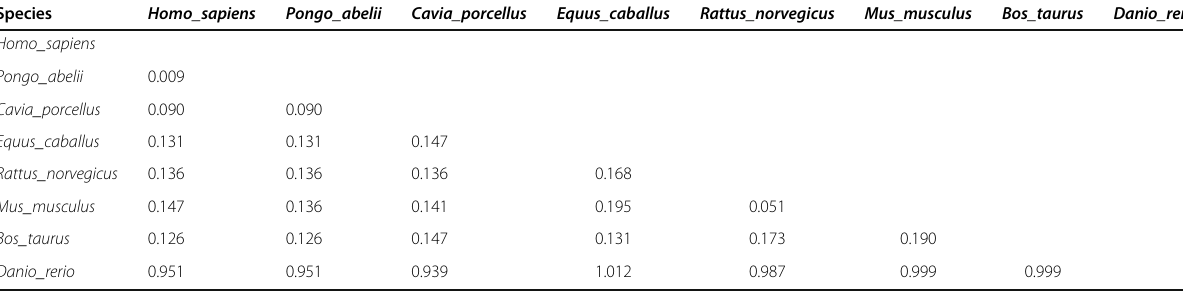
Table 1 Evolution distance of PRRT2 protein between different species